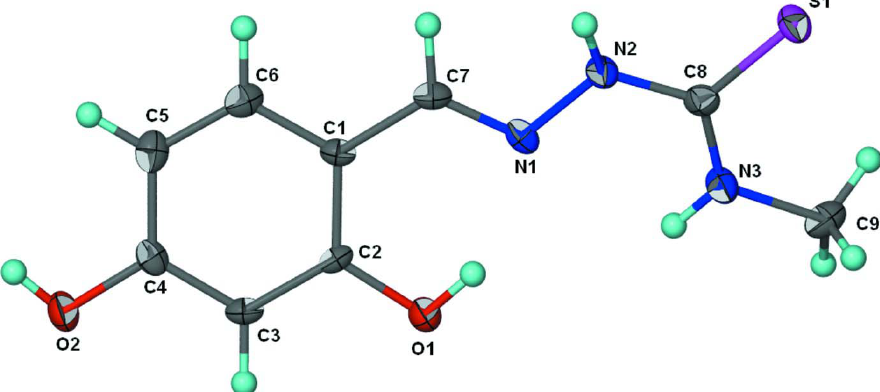
Thermal ellipsoid (Barbour, 2001) plot of (I) drawn at the 70% probability level. Hydrogen atoms are drawn as spheres of arbitrary